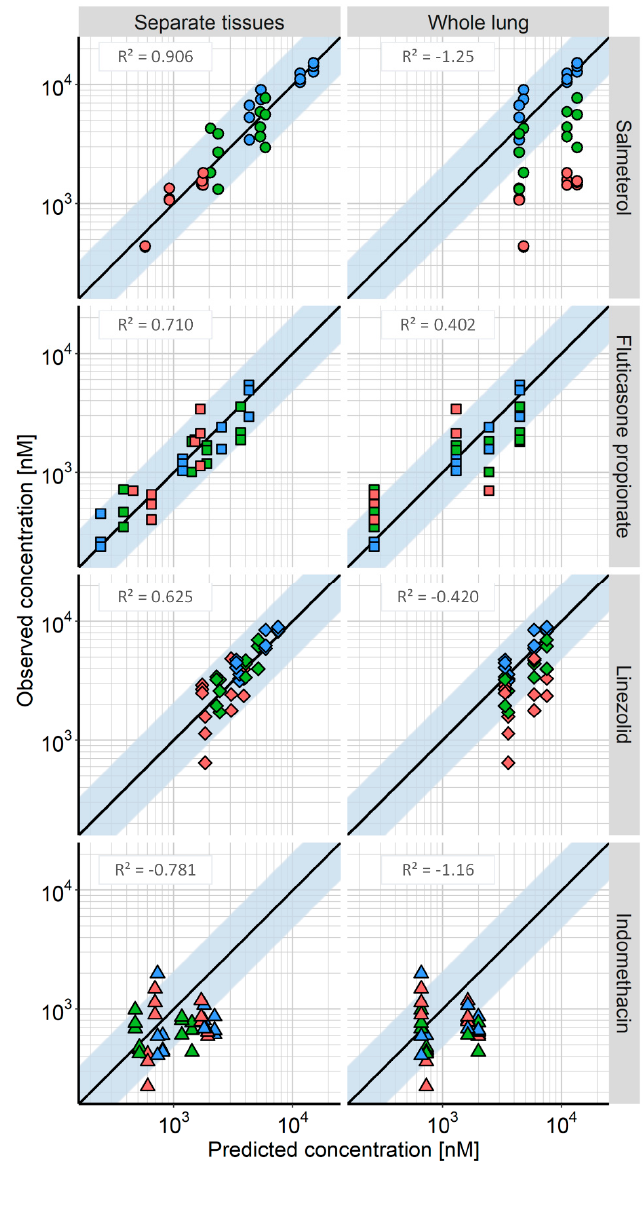
Figure 4. Goodness-of-fit plots of observed vs. predicted concentrations in the trachea (red), bronchi (green), and alveolar parenchyma (blue). Observed localized pulmonary concentrations plotted against (left) the predictions of concentrations in the separate pulmonary tissues; and (right) against predictions of total lung concentrations. Circles: salmeterol, squares: fluticasone propionate, diamonds: linezolid, triangles: indomethacin. The shaded area shows the two-fold error range.